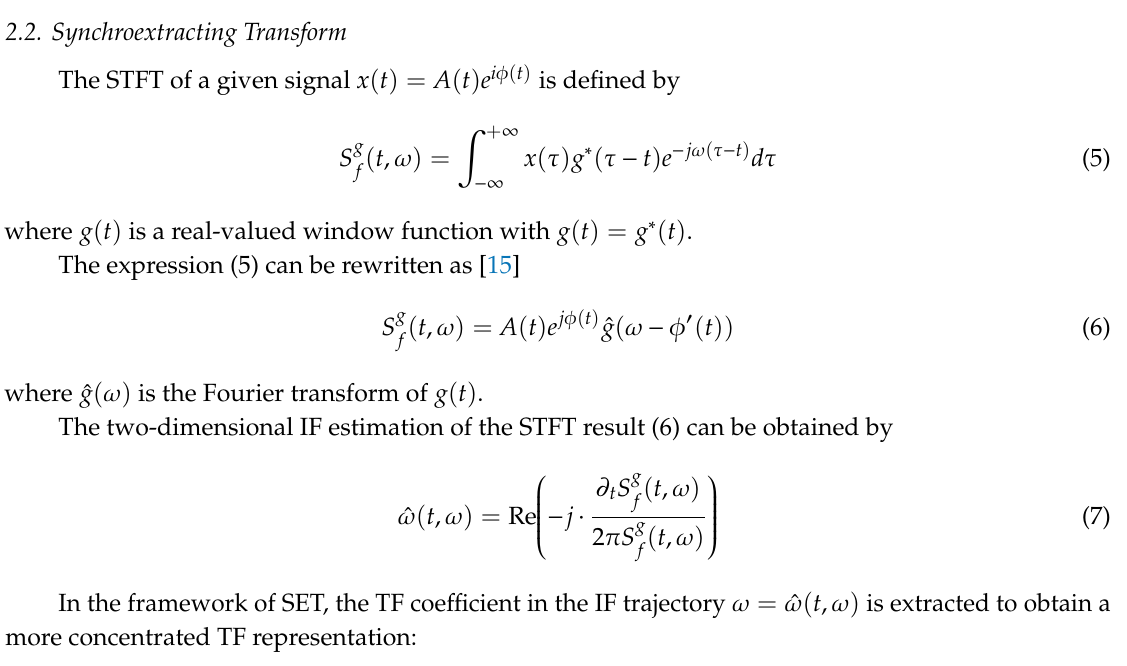
Figure 1. The micro-motion model of cone-shaped target.